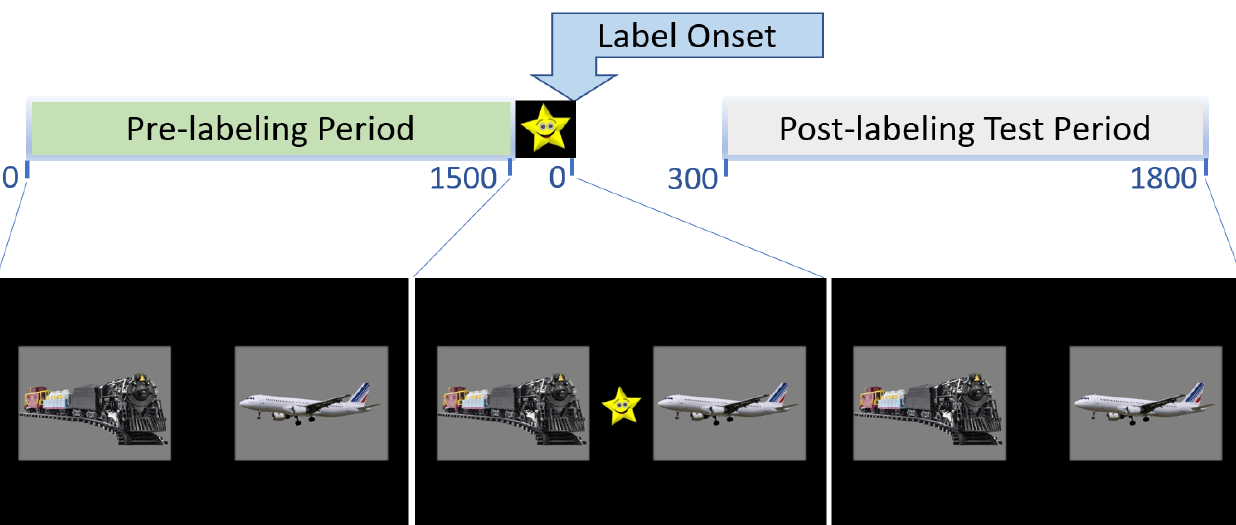
Figure 2. Example of visual stimuli in an experimental trial. Each trial began with a pre-labeling period, during which target and distractor images appeared alone, side by side. After 1500 ms, a salient central image (e.g., smiling star) appeared. Simultaneously, the attention getting auditory stimulus “Look!” was presented. Once the toddler fixated on the central image for 100 ms, it disappeared. Then, the spoken label for the target was presented, followed by an encouraging phrase (e.g., “Train! You’re doing great!”). The post-labeling test period then went from 300 to 1800 ms post naming onset.